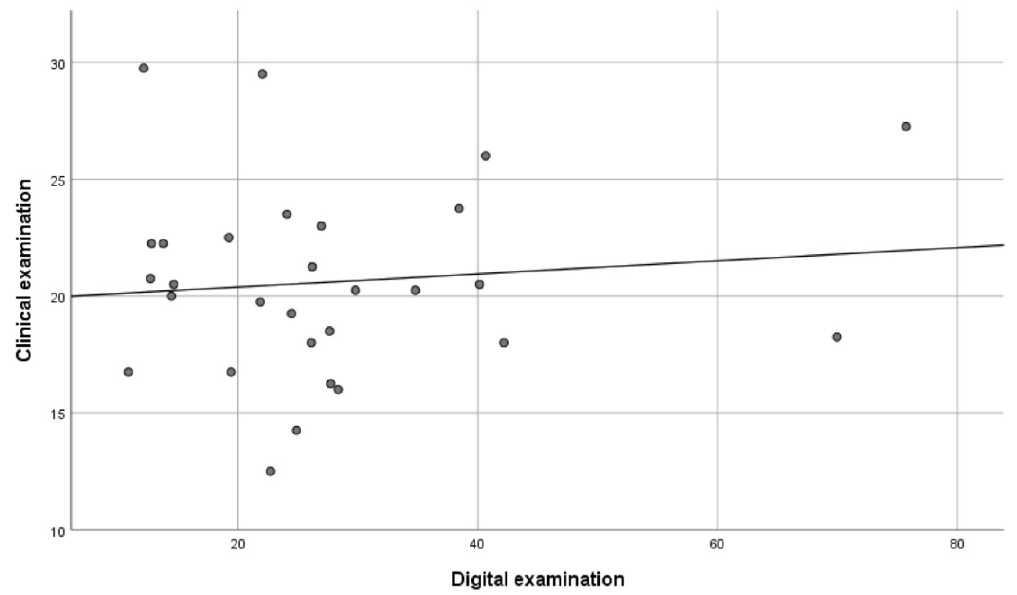
Figure 5. Scatterplot explaining the relationship between the total amount of occlusal contacts in the clinical examination and the total amount of occlusal contacts in the study cast examination ( n = 29). Every dot represents one of the included participants ( p < 0.05).